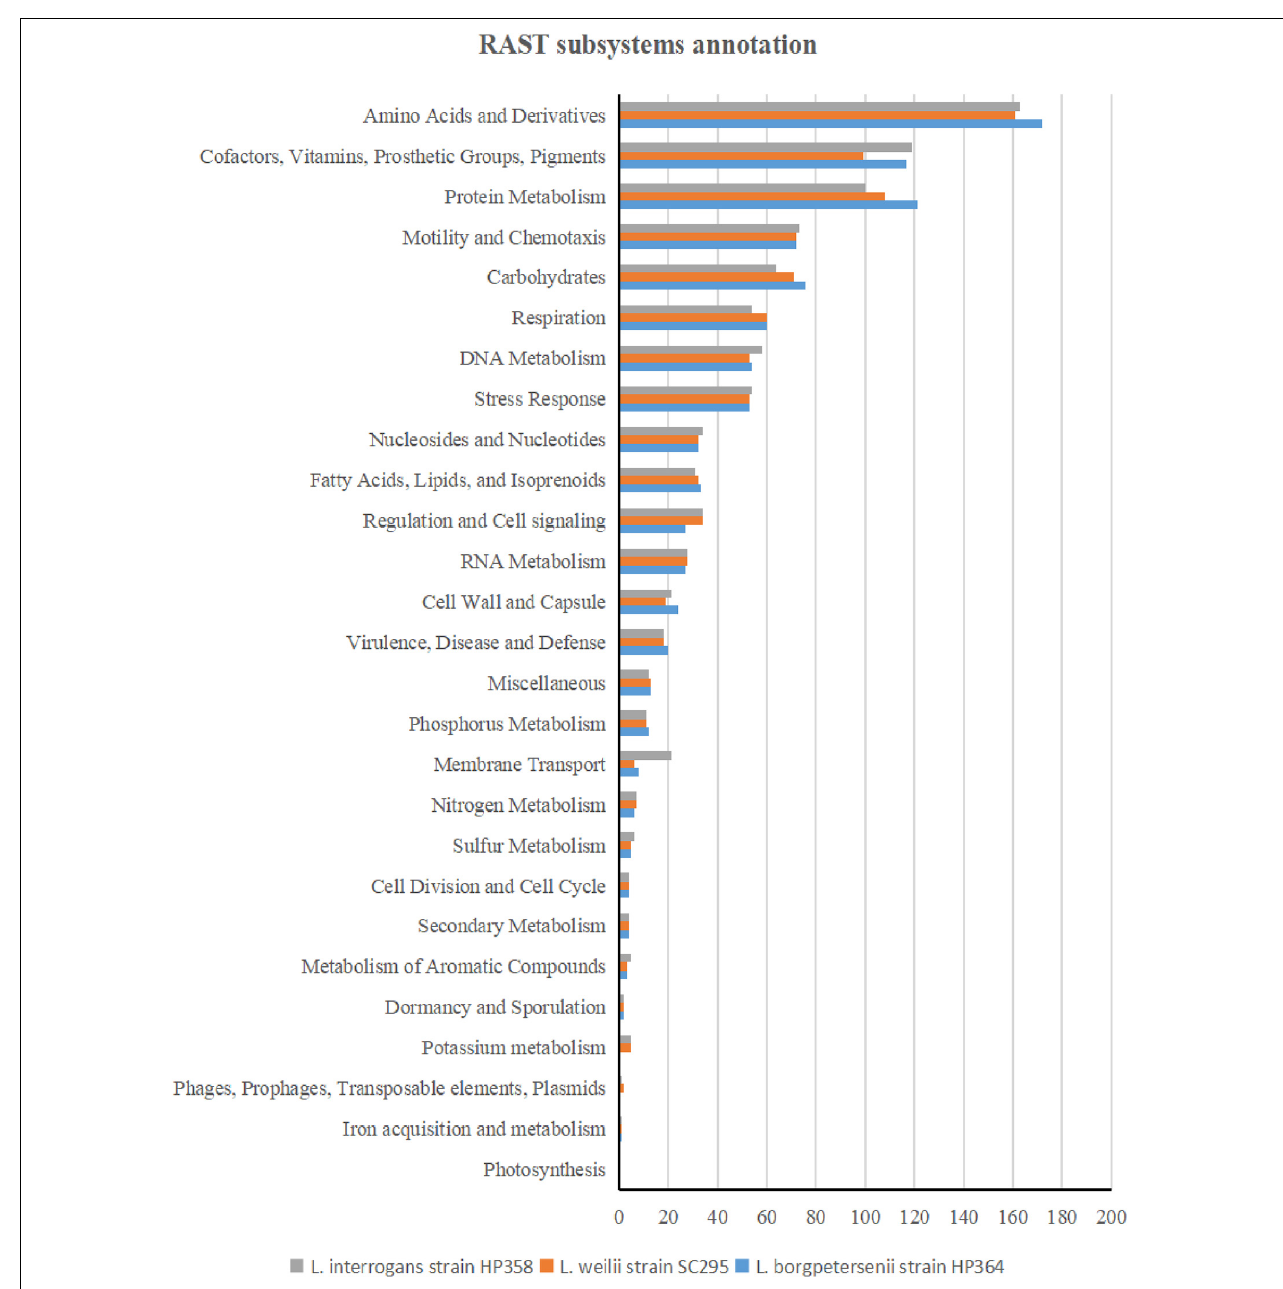
FIGURE 5 | RAST subsystem annotation in L. borgpetersenii strain HP364, L. weilii strain SC295, and L. interrogans strain